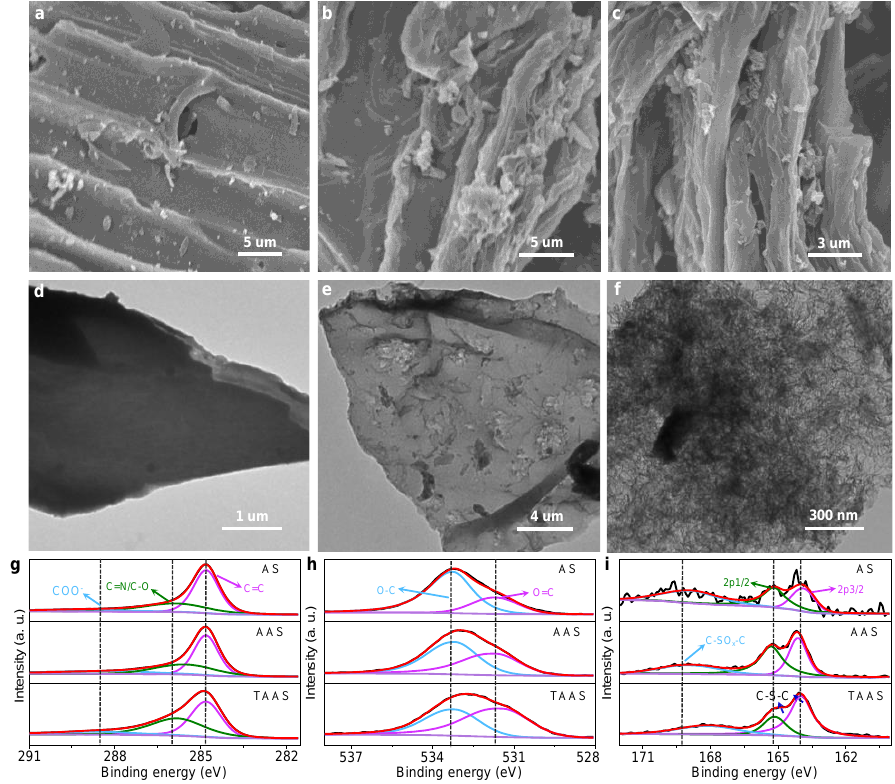
Figure 1. SEM images of AS ( a ), AAS ( b ) and TAAS ( c ). TEM images of AS ( d ), AAS ( e ) and TAAS ( f ). High-resolution XPS spectrum for the C 1s ( g ), O 1s ( h ) and S 2p ( i ) peaks of AS, AAS and TAAS.